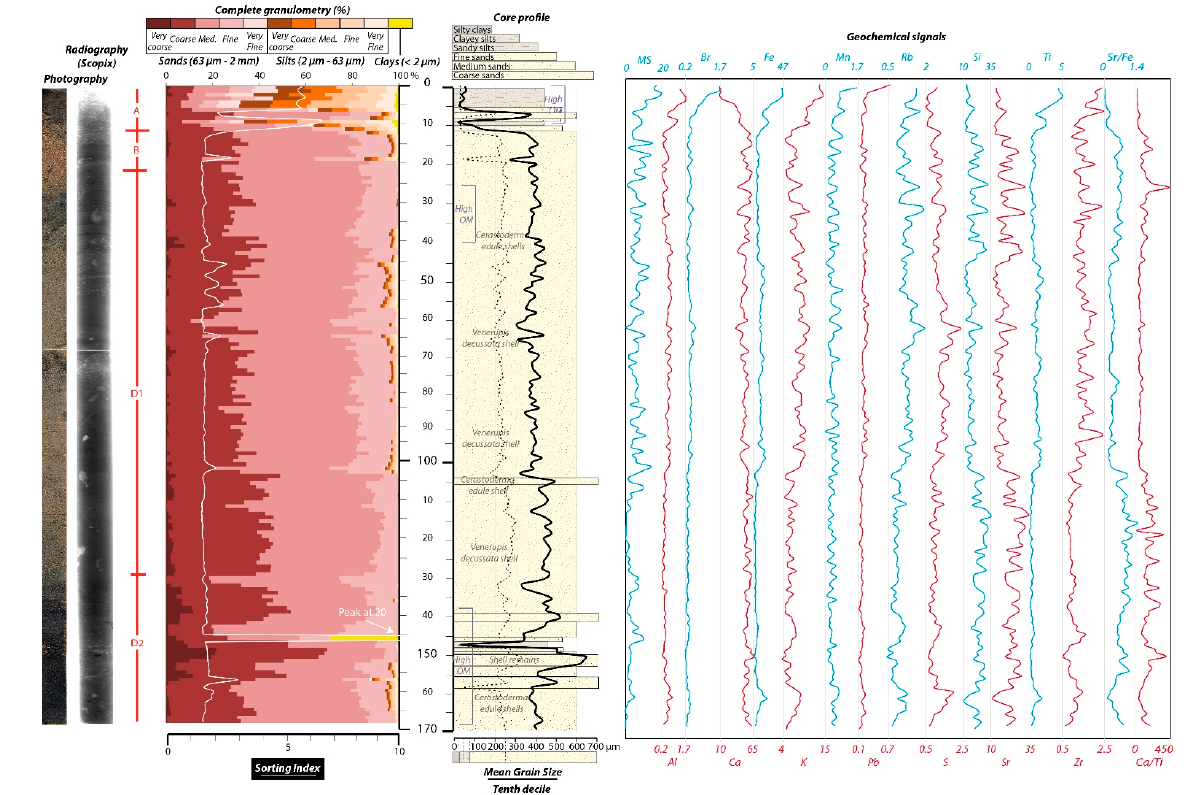
Figure 7. BH-A core log with photography, radiography, grain size results, and geochemical signals.